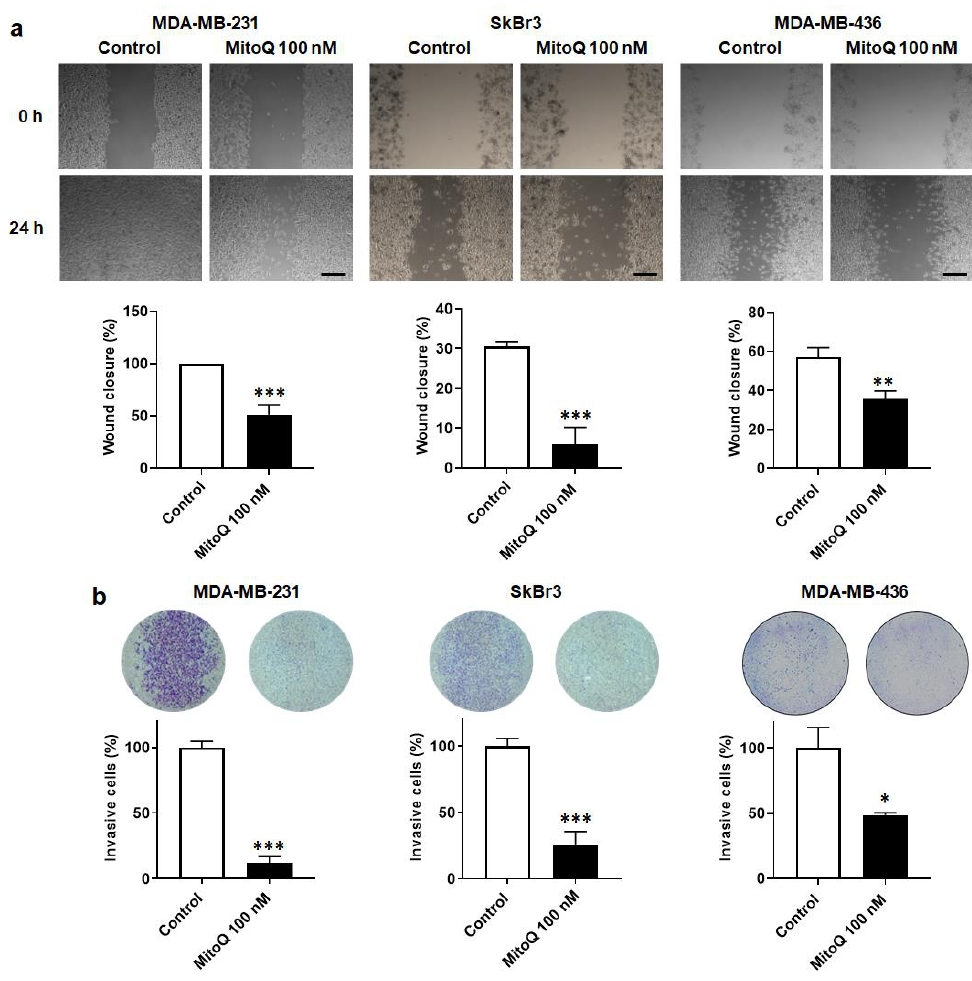
Figure 5. MitoQ represses human breast cancer cell migration and invasion. Cells were treated for 48 h ± MitoQ (100 nM). ( a ) MDA-MB-231 (left, n = 6), SkBr3 (middle, n = 3–8) and MDA-MB-436 (right, n = 10–13) cancer cell migration over 24 h was determined using a scratch assay. Representative pictures are shown on top and quantification graphs on the bottom. Bars = 50 µm. ( b ) MDA-MB-231 (left, n = 3), SkBr3 (middle, n = 3) and MDA-MB-436 (right, n = 3) cancer cell invasion was quantified in a Boyden chamber assay. Representative images are shown together with overnight invasion data. All data are shown as means ± SEM. * p < 0.05, ** p < 0.01, *** p < 0.001 compared to control; by Student t -test ( a , b ).